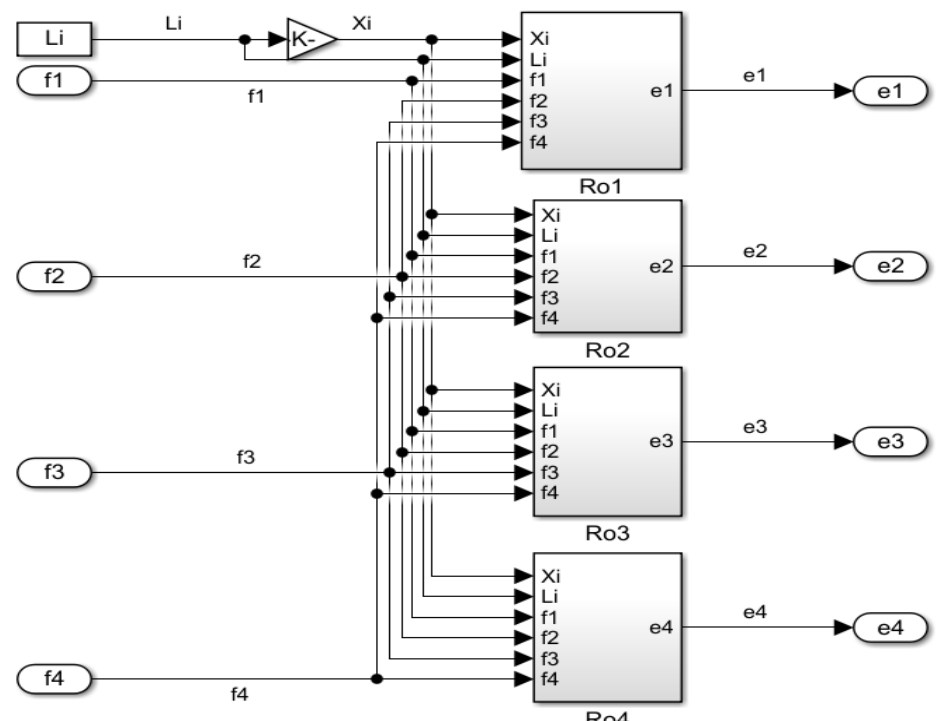
Figure 6. Blade structural model including aerodynamic loads in MATLAB/Simulink.